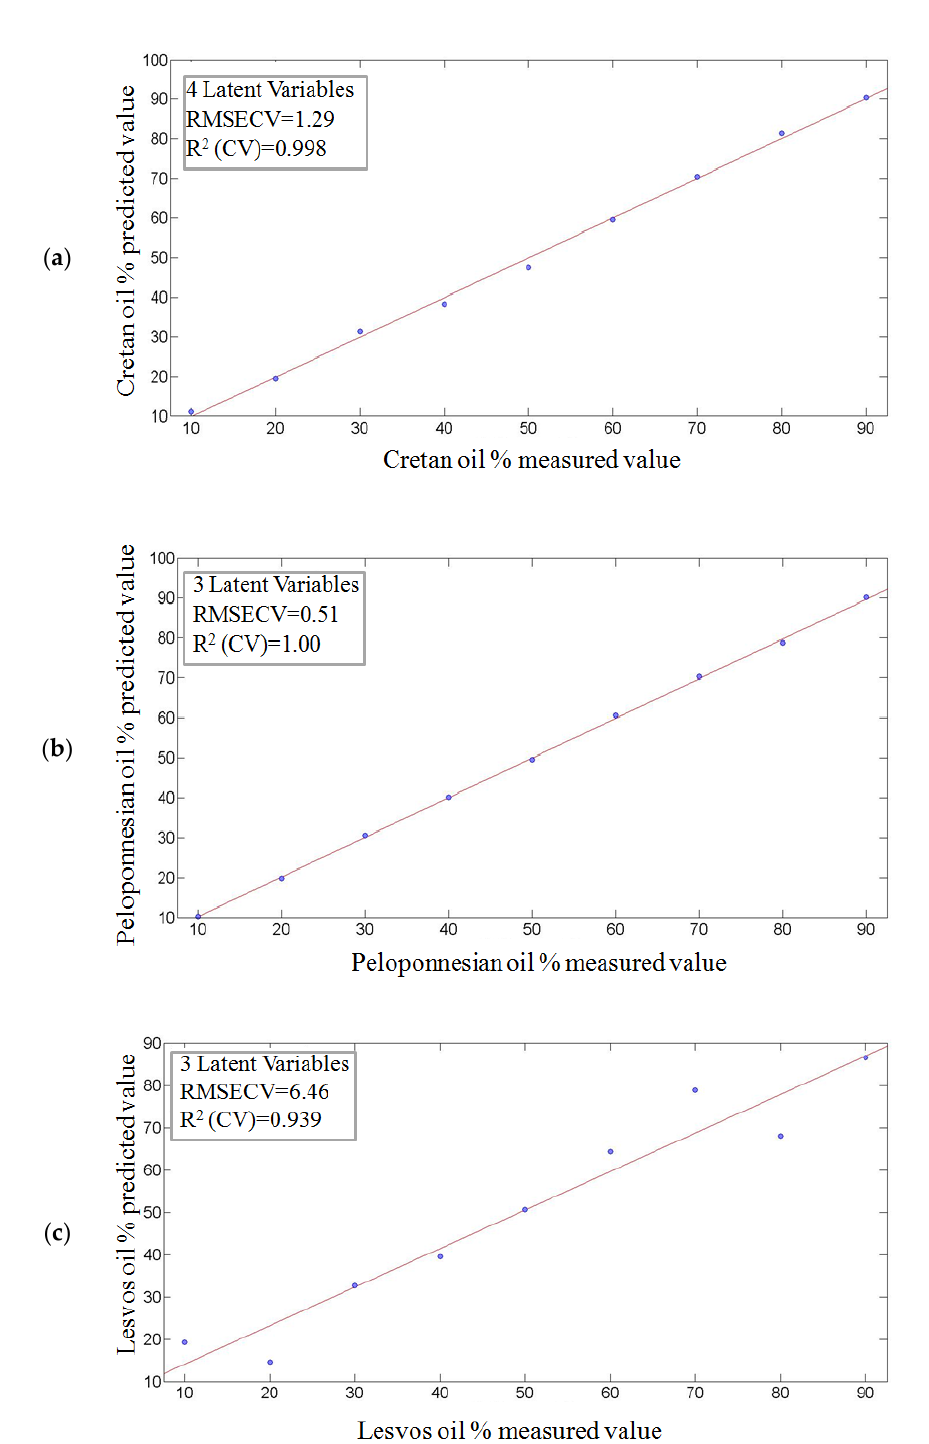
Figure 7. Predicted versus actual concentrations of the olive oil mixtures (% v / v ) resulting from PLS model application on visible absorption spectral data ( a ) from Crete and Peloponnese, ( b ) from Peloponnese and Lesvos, and ( c ) from Crete and Lesvos.